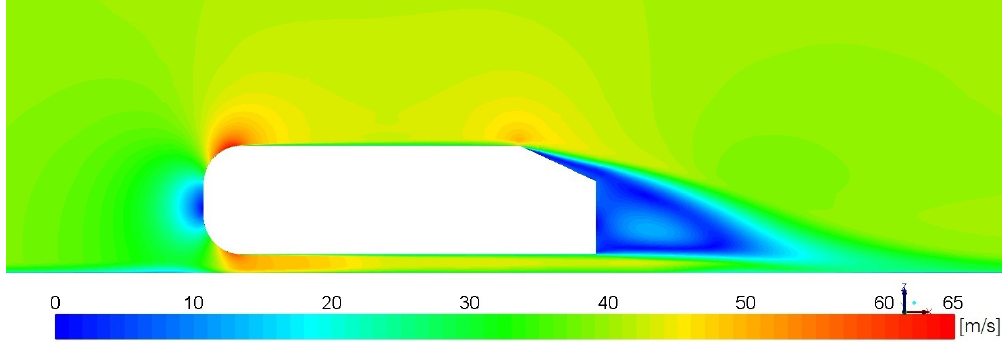
Figure 5. Velocity distribution around the Ahmed body at the symmetry